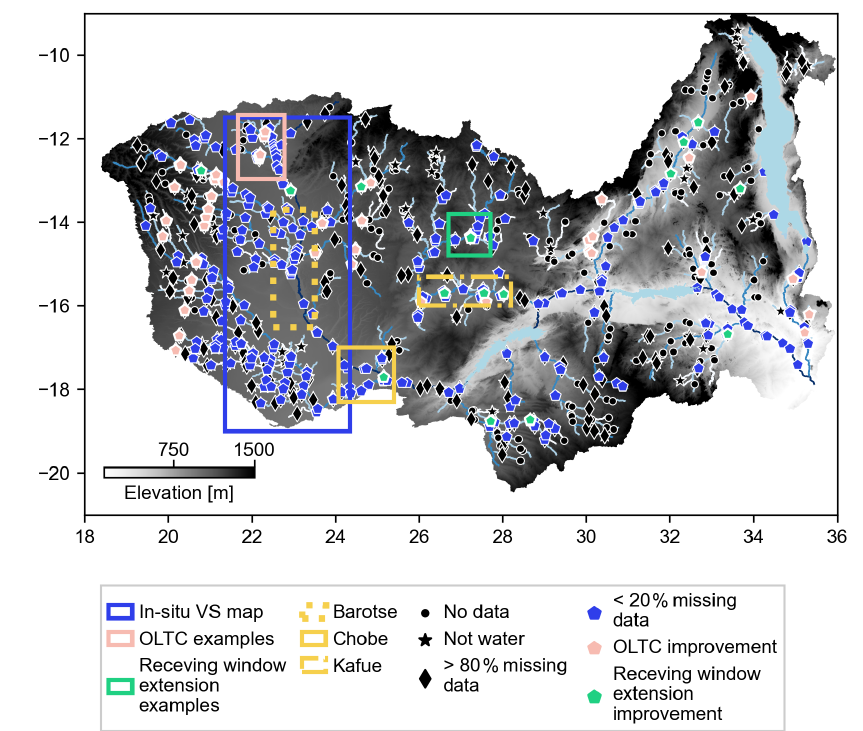
Figure 3. Zambezi Sentinel-3A and 3B VSs after outlier filtering. Stations that improved by modifying processing steps (either on board through the Sentinel-3A OLTC update or on ground by extending the receiving window on GPOD) are highlighted separately. The frames indicate examples highlighted in the next sections of this study. Additional maps are included in the Appendix (Figs.